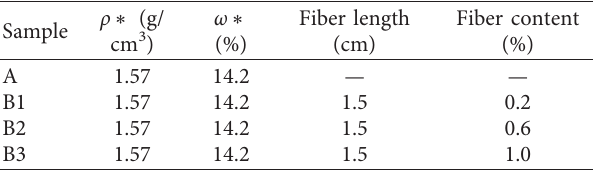
Figure 1: Palm fiber used in this study. Table 2: Basic parameters of the